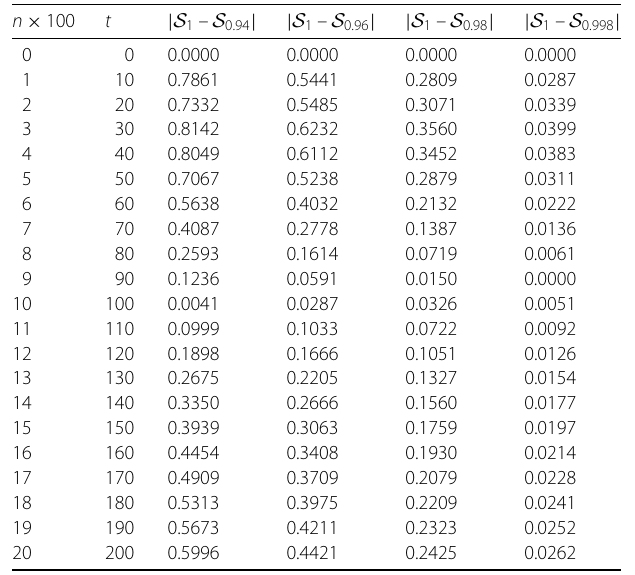
Table 2 The values of | S 1 – S φ | for φ = { 0.94,0.96,0.98,0.998